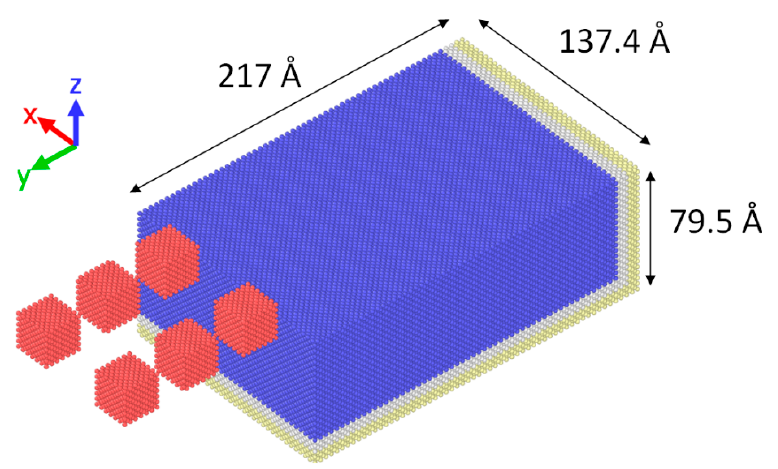
Figure 1. Schematic of the Molecular Dynamics (MD) model.